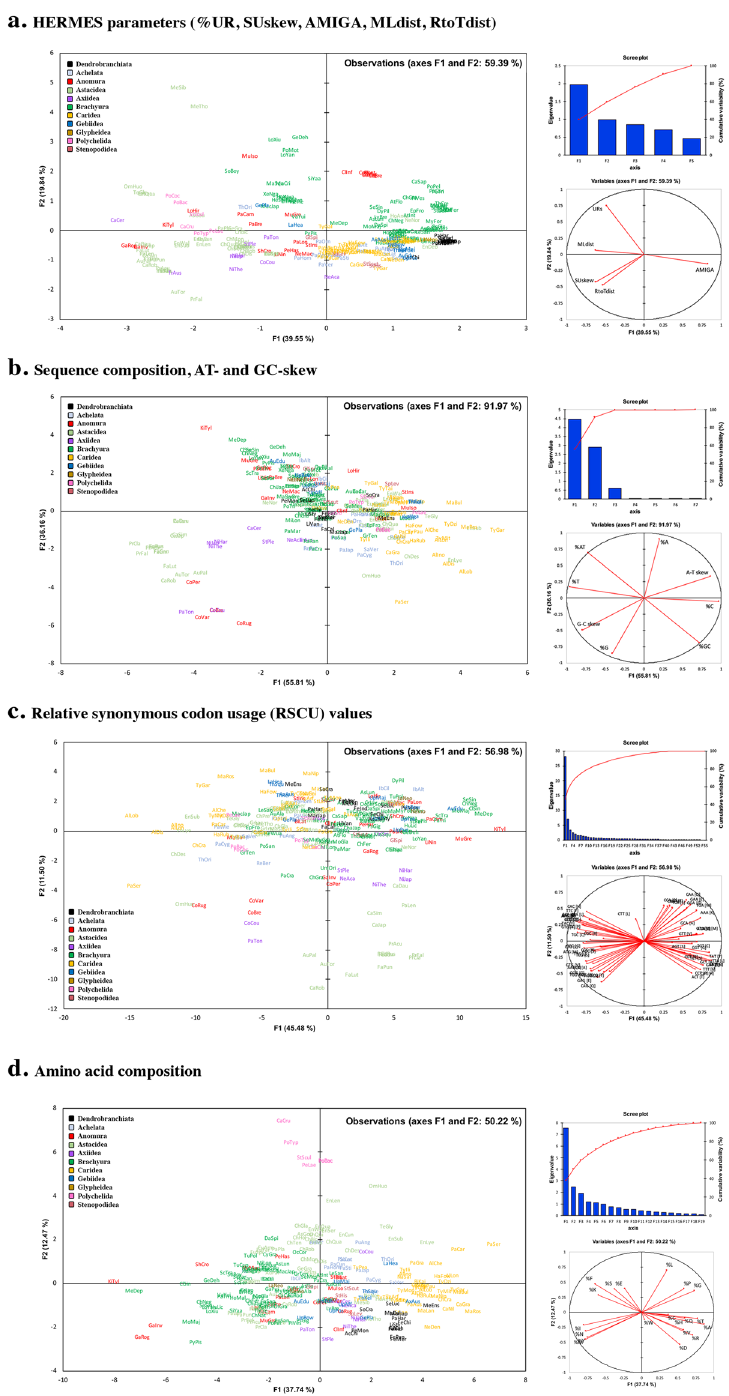
Figure 4. Mitogenomic PCA plots. Principal component analyses using Pearson’s correlation based on various characteristics of the mitogenome. ( a ) shows the PCA plot based on the same five variables in the HERMES analysis, with the first two principal components accounting for 59.39% of the dataset variability. Additionally, ( b – d ) summarise nucleotide composition, asymmetry (skew) information and amino acid composition with 91.97%, 56.98% and 56.98% of each dataset variability, respectively, in the first two principal components. Data points are labelled with the first 2 or 3 letters of the genus followed by the first 3 letters of the species name; e.g. ‘ ChDes ’ for Cherax destructor